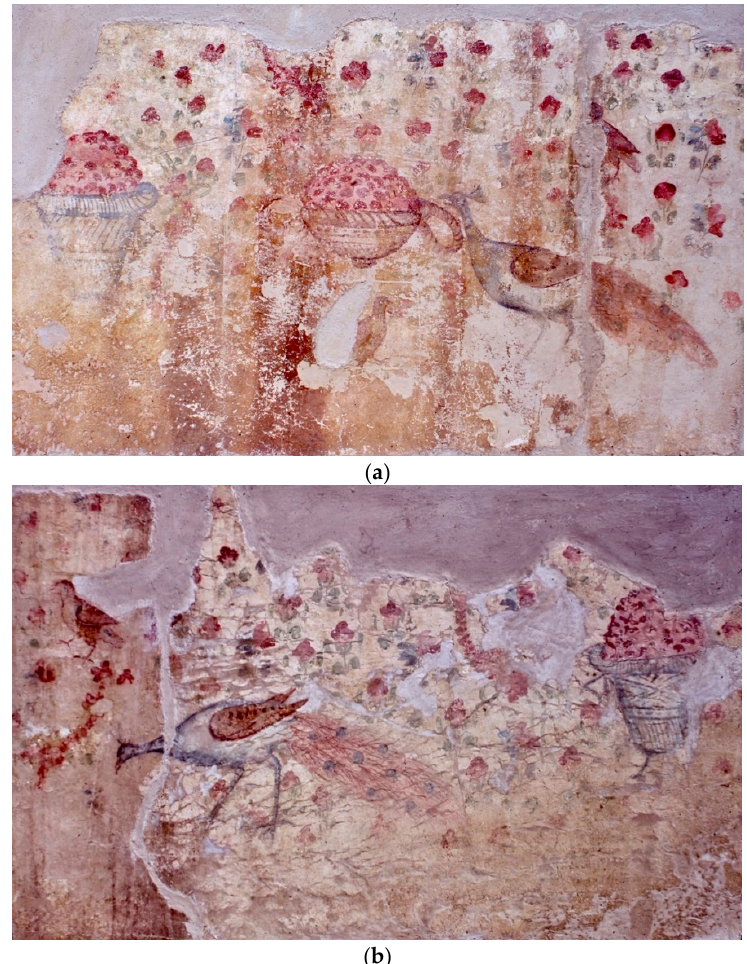
Figure A1. Sardis, “Peacock tomb” (Tomb 61.14, Appendix A.3), sections removed to the Manisa museum, ( a ) north wall; ( b ) south wall. © Archaeological Exploration of Sardis/President and fellows of Harvard College. Arts 2019 , 8 , x FOR PEER REVIEW